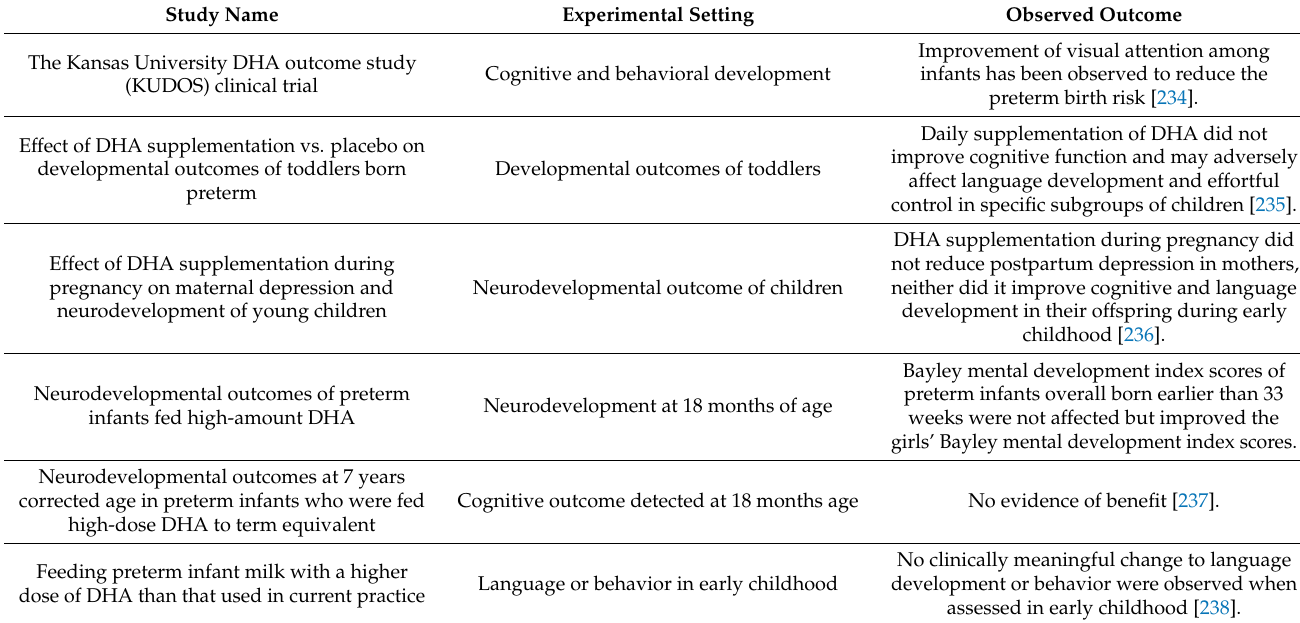
Table 2. Various clinical studies of DHA supplementation in mothers and infants about brain